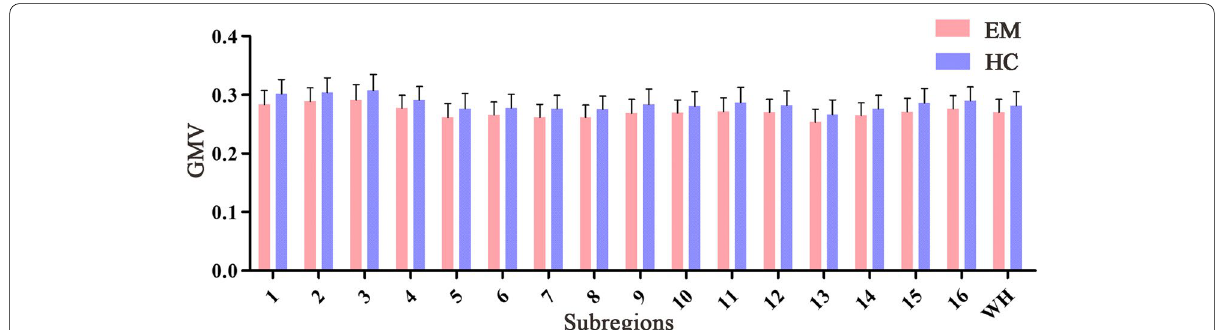
Fig. 4 Between-group comparisons of the GMV of the thalamic subregions and whole thalamus. Abbreviations: GMV, grey matter volume (mm 3 ); WH, whole thalamus; EM, episodic migraine; HC, healthy control. The error bars indicate the standard deviation. 1–16 represent L(R) mPFtha, L(R) mPMtha, L(R) Stha, L(R) rTtha, L(R) PPtha, L(R) Otha, L(R) cTtha, and L(R) lPFtha,